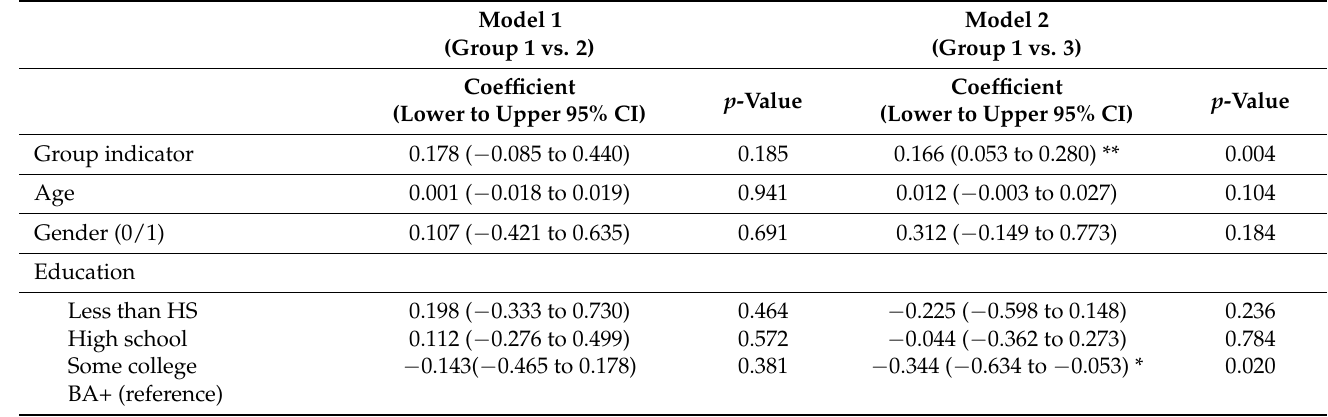
Table 4. Predicting Intention to Quit Smoking with Current Cigarette